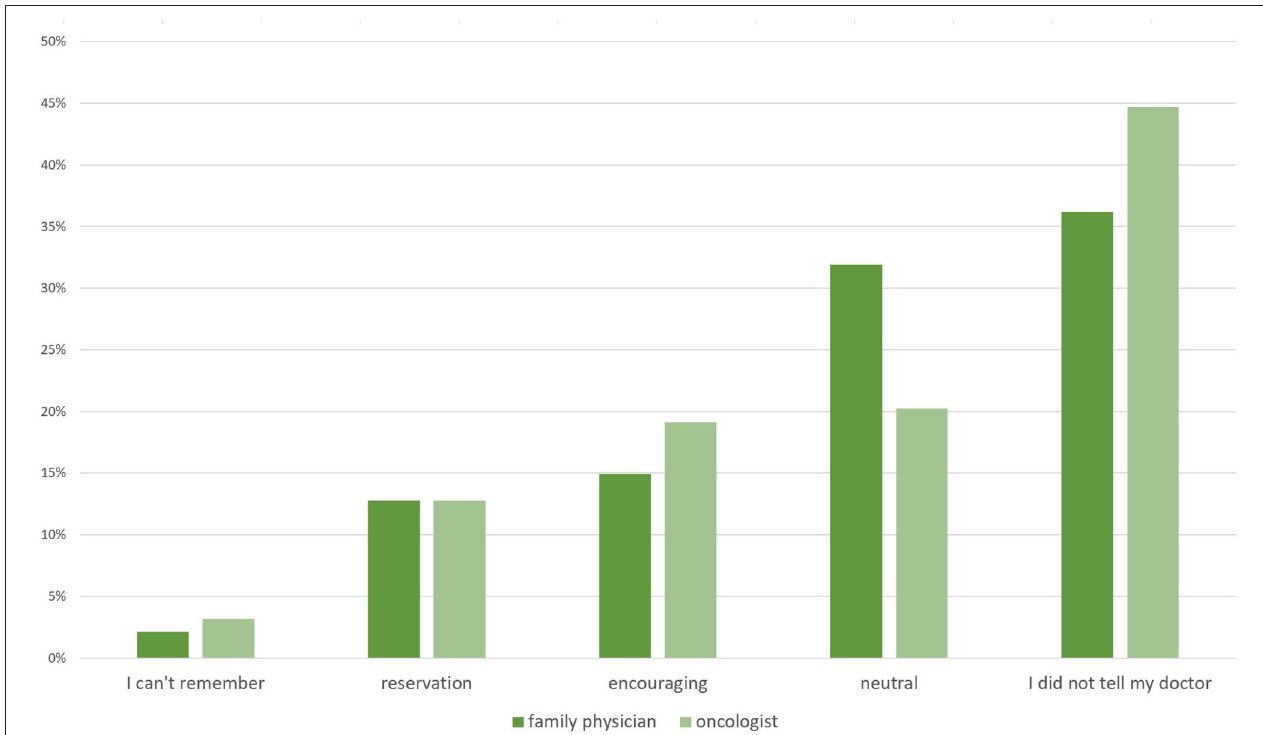
FIGURE 4 | Responses to the question of how their family physicians and oncologists reacted when informed that the patient had switched to a KD or similar LC diet ( n =